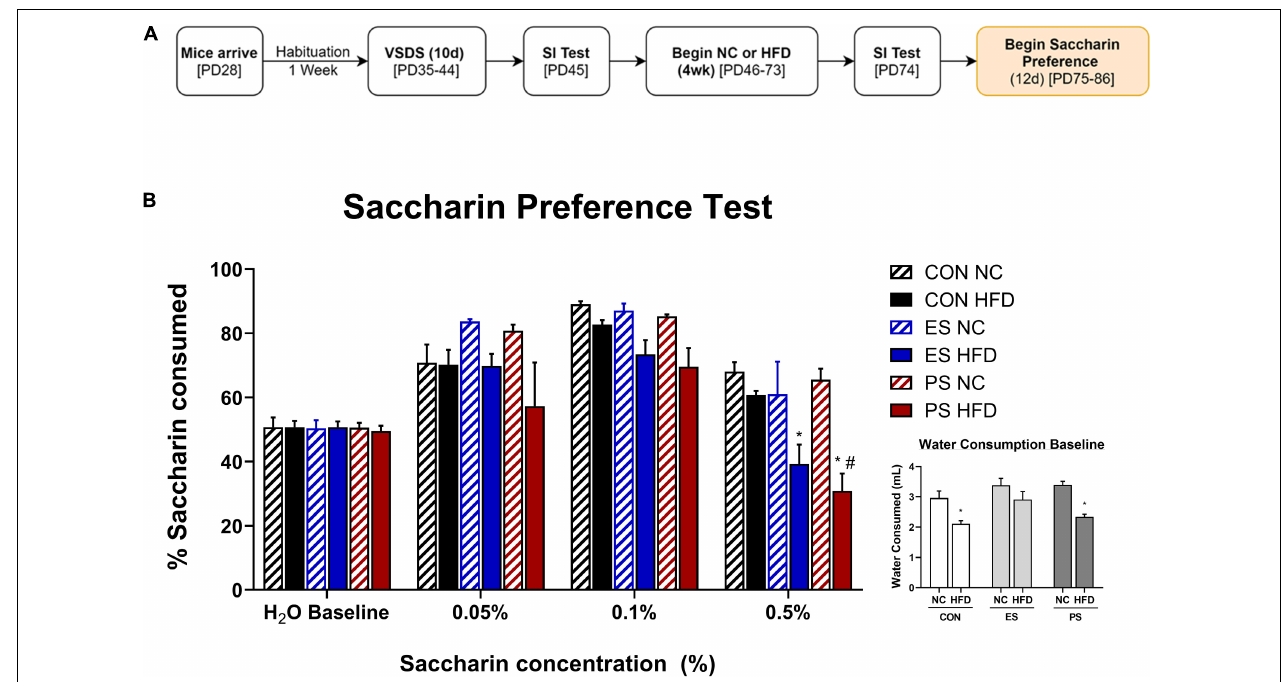
FIGURE 3 | Effect of VSDS exposure followed by HFD on preference on saccharin. (A) Adolescent mice ( n = 6/group) were used to further assess the effects of VSDS + HFD exposure on reward sensitivity using a two-bottle saccharin preference test. (B) There were no differences between any group in percentage of water consumed at baseline. In addition, no significant differences were observed at the 0.05 and 0.1% saccharin concentration. However, at the 0.5% concentration, both the ES + HFD- and PS + HFD-exposed mice consumed significantly less saccharin as compared to the CON + NC group ( post hoc , p < 0.05). A MANOVA revealed differences in preference for the sweetened solution as a factor of saccharin concentration ( main effect; p < 0.05); and diet ( main effect; p < 0.05). Only the PS + HFD-exposed mice showed a significant difference when compared to the mice in the CON + HFD condition ( post hoc p < 0.05). Inset graph shows the raw consumption during the water baseline. A two-way ANOVA revealed that the CON + HFD- and the PS + HFD-exposed mice drank less water than their NC-counterparts ( post hoc p < 0.05). Mice in the ES + HFD condition trended toward a decrease, but this was not significantly different from the ES + NC-exposed mice ( post hoc p > 0.05). Despite the HFD-induced adipsia, the relative percentage of saccharin consumed remained lower in the stressed group exposed to HFD. These findings indicate that concurrent stress and HFD exposure results in dysregulated sensitivity to reward (i.e., saccharin), independent of the caloric value of the sweetened solution. * p < 0.05: significantly different from CON + NC; # p < 0.05: significantly different from CON + HFD.